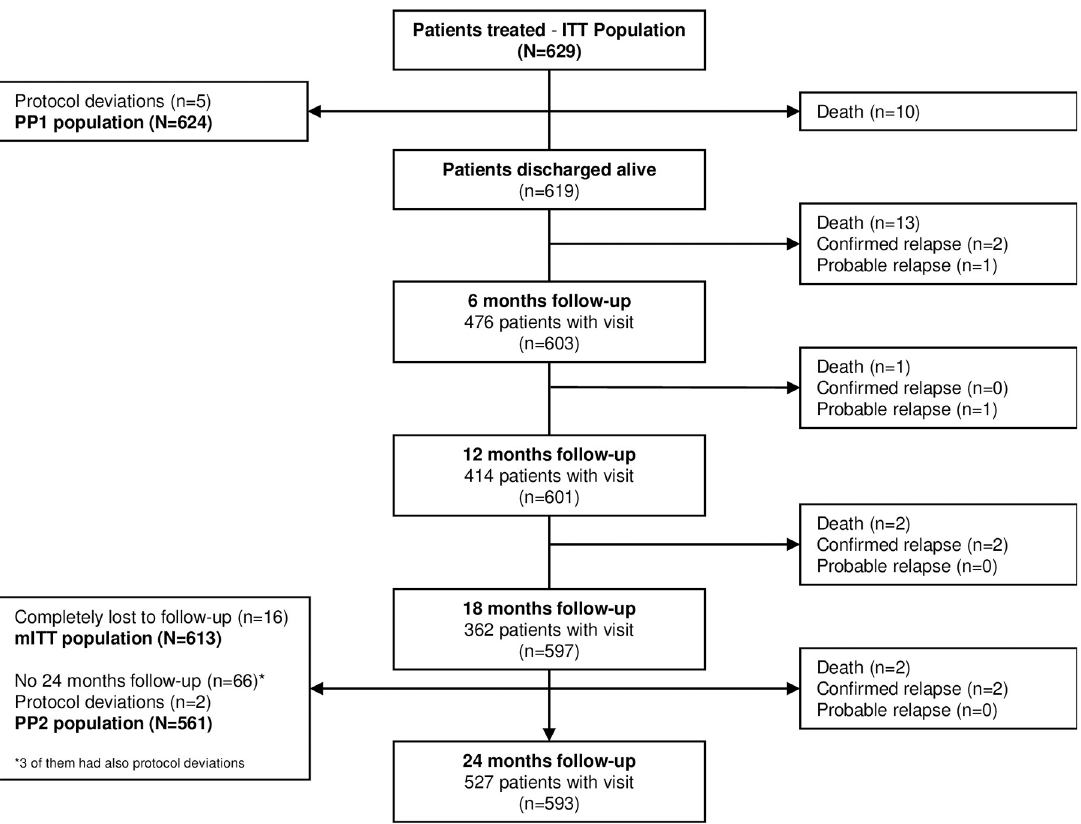
Fig 1. Flow diagram of the study population Screening flowchart is shown in the in-hospital publication [15].